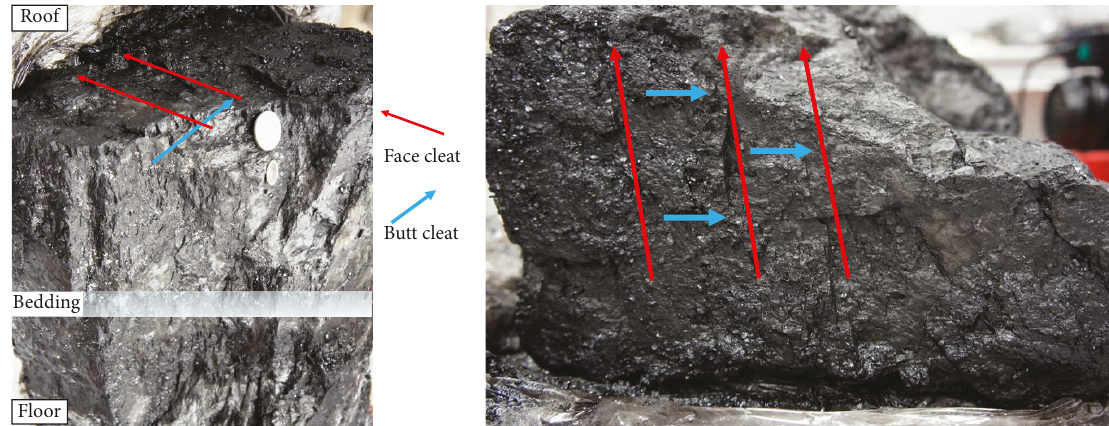
Figure 3: Picture of the lump coal samples showing the cleat systems relative to the coal bedding direction (Ref.